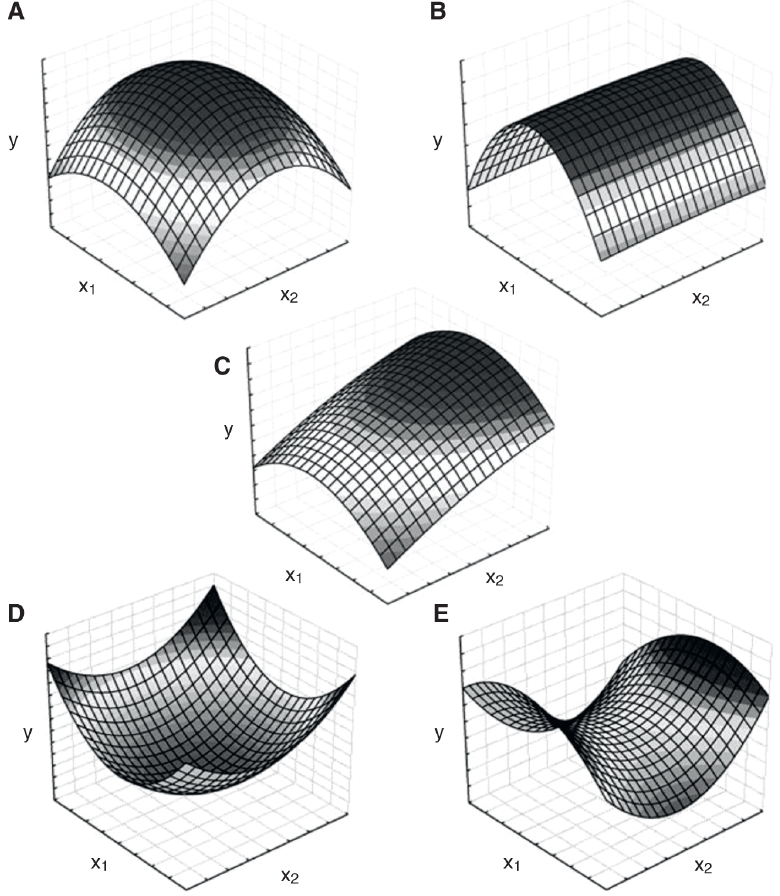
Figure 6: Response surfaces: some profiles of surface response generated from a quadratic model in the optimization of two variables. (A) maximum, (B) plateau, (C) maximum outside the experimental region, (D) minimum and (E) saddle surfaces